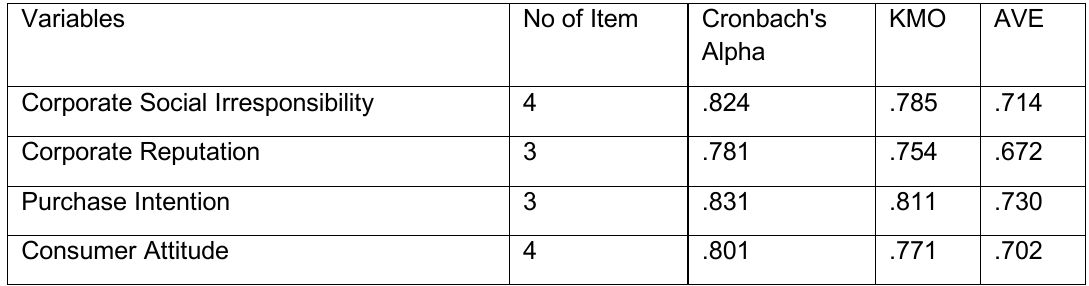
Table 1b: Result of Cronbach's Alpha and KMO